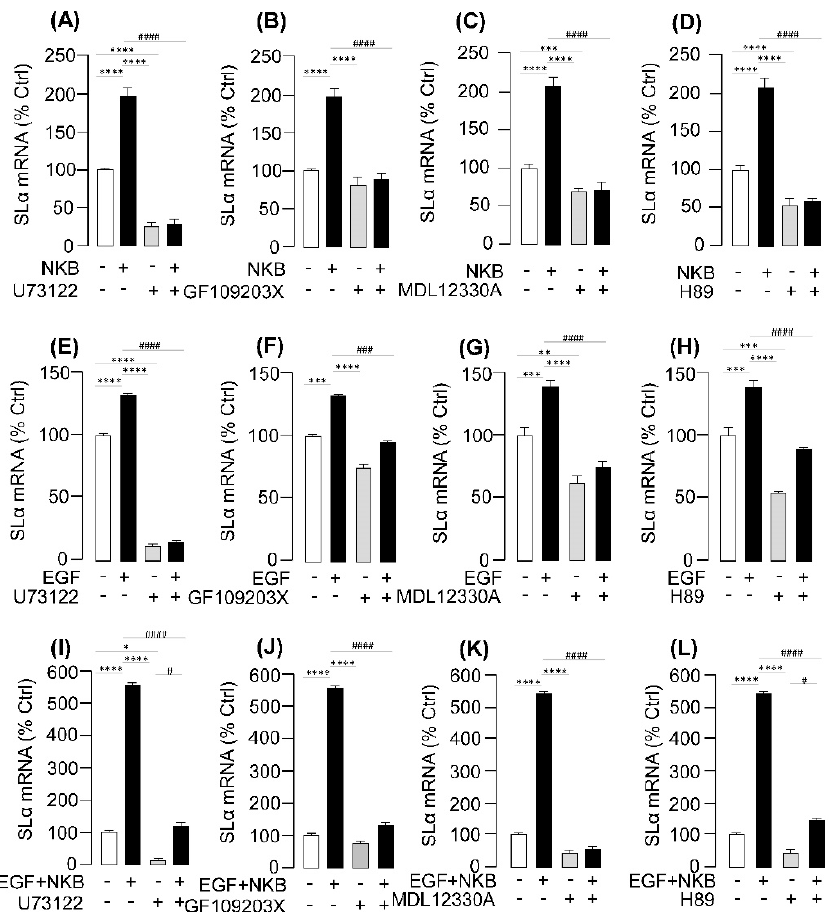
Figure 7. Signal transduction mechanisms of EGF potentiation of NKB-induced SL α mRNA expression. ( A ) Effects of 24-h treatment with the PLC inhibitor U73122 (10 µ M) or PKC inhibitor GF109203X (10 µ M) on EGF (10 nM), and NKB (1 µ M) + EGF (10 nM)-induced SL α mRNA expression were examined in grass carp pituitary cells. ( B ) Effects of 24-h co-treatment with AC inhibitor MDL12330A (10 µ M) or PKA inhibitor H89 (10 µ M) on NKB (1 µ M) + EGF (10 nM)-induced SL α